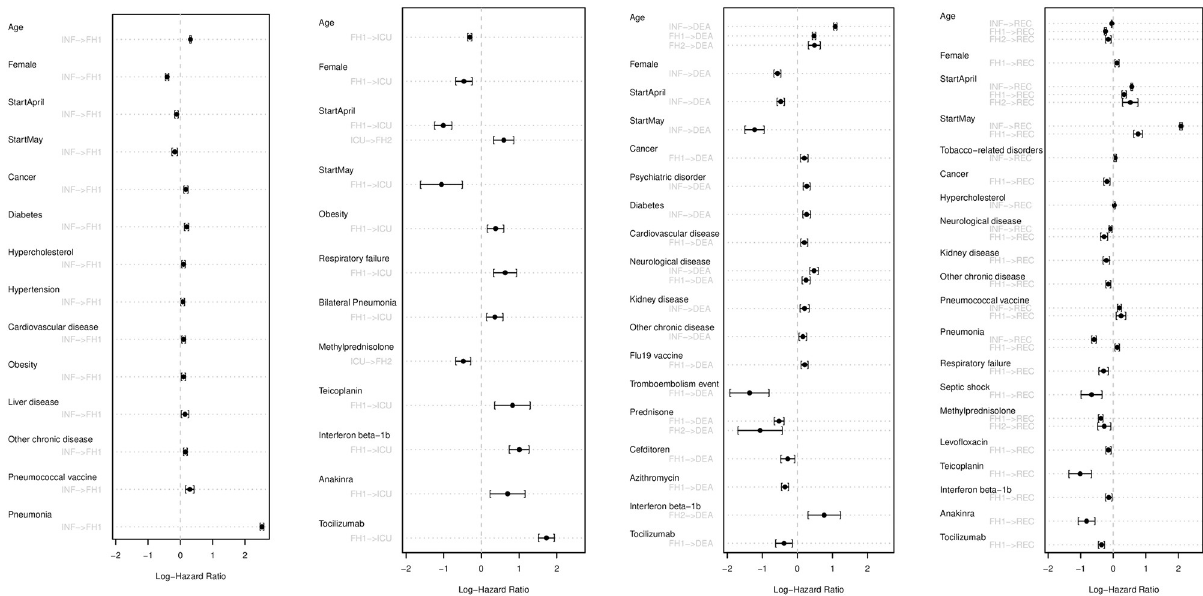
Fig 2. Confidence intervals for the log-hazards of each covariable split by transitions. From left to right, each panel shows parameters associated to the hazard to transition to hospitalisation, parameters associated to intensive care admission, parameters relevant to death and related to recovery.